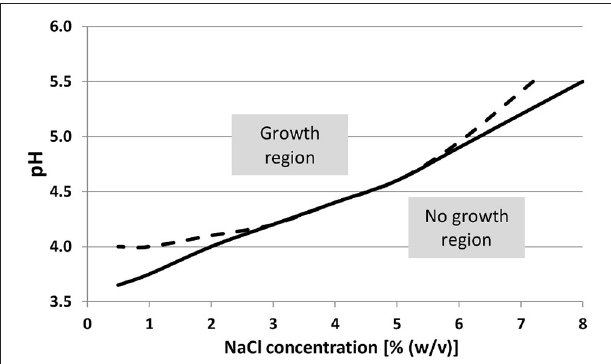
FIGURE 3 | Growth/no growth regions of Salmonella Typhimurium in TSB (tryptic soy broth) at 20 ◦ C as a function of pH and NaCl concentrations, with gelatine concentrations of 0 and 50g/l. Adapted from Theys et al. (2010).